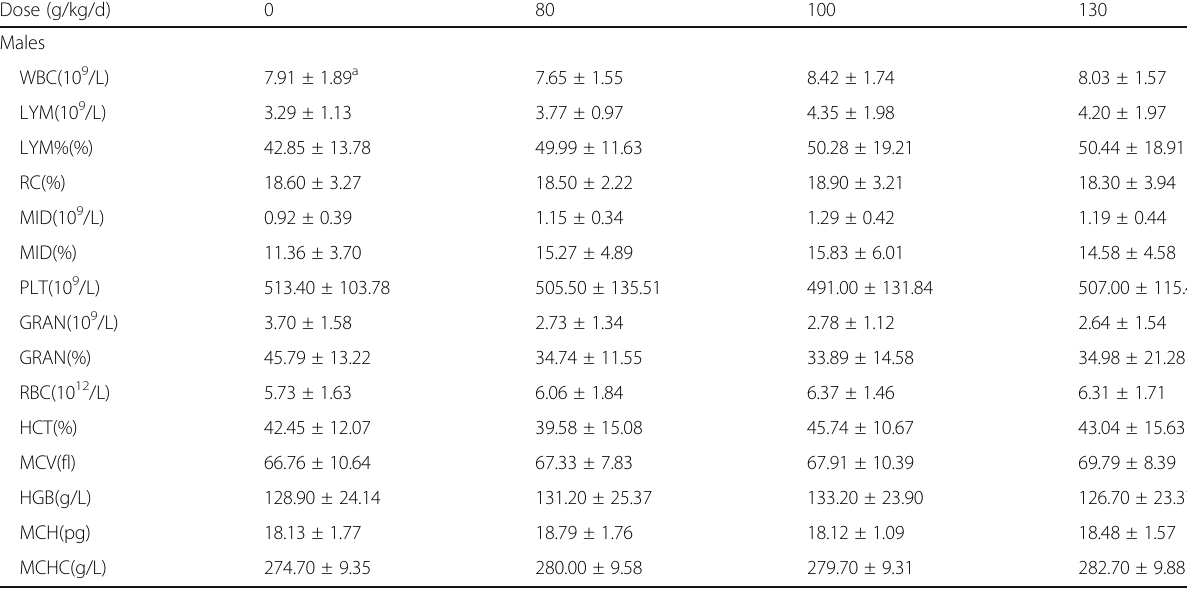
Table 6 Hematological data for male rats treated with JDHY granules for 13 weeks of treatment Dose (g/kg/d)